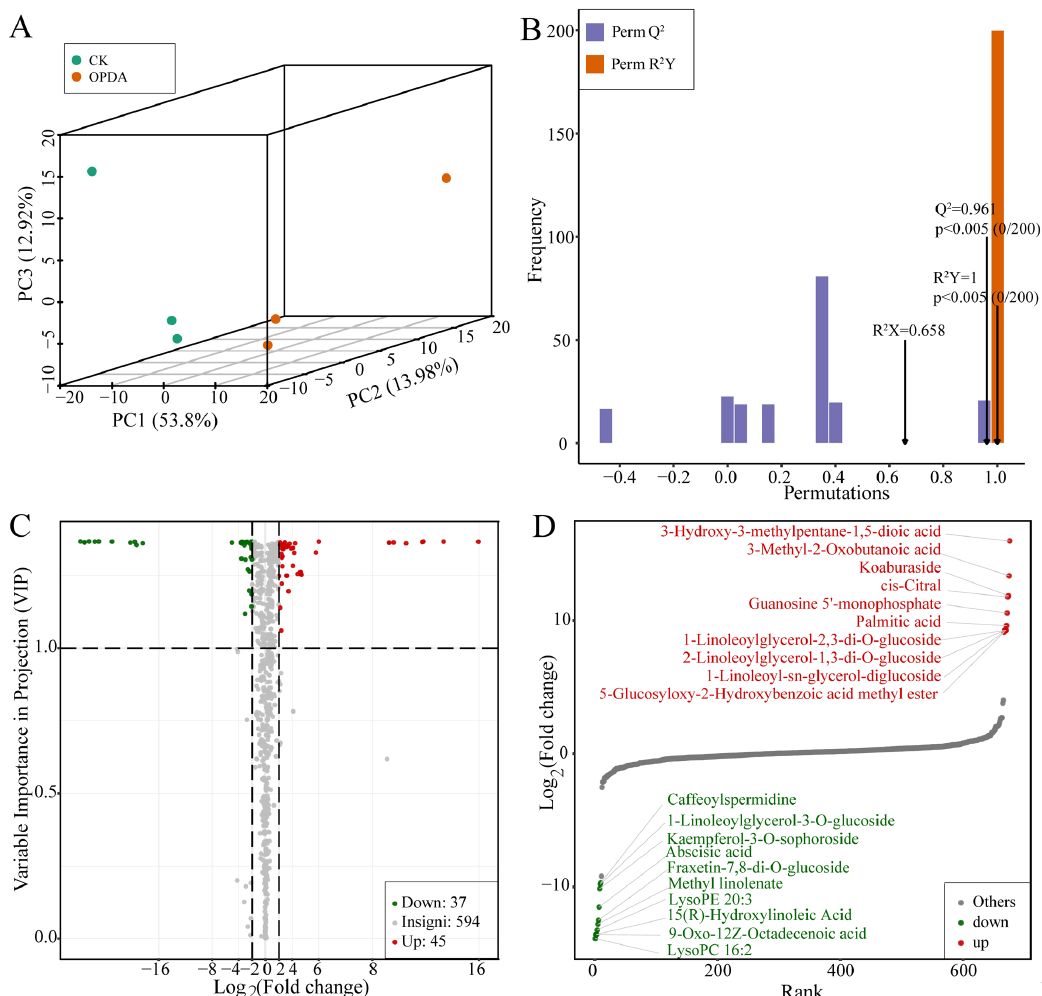
Figure 1. Identification of differently accumulated metabolites in Pohlia nutans under OPDA treatment. ( A ) Principal clustering analysis for OPDA treatment and control groups. CK, control group; OPDA, OPDA treatment group. ( B ) OPLS-DA was used to supervise and calculate variables respon- sible for group differences. R 2 X and R 2 Y represent the interpretation rate of X and Y matrix, respec- tively, while Q 2 Y indicates the prediction ability of the model. The model is more stable and reliable if the value is closer to 1. Additionally, a model with Q 2 Y > 0.5 is considered effective, and a model with Q 2 Y > 0.9 is considered excellent. ( C ) Volcanic plot showing metabolite contents and statistical significance. Each point represents a metabolite. A horizontal ordinate represents the fold change in metabolites between two groups, while a VIP value indicates a significant difference in statistical analysis. ( D ) The top 20 differently changed metabolites between two groups were selected with the values of fold change. We found 82 significantly changed metabolites (SCMs), with 45 upregulated and 37 downregulated, between the treatment and control with the criteria of |log 2 Fold Change| ≥ 1 and variable importance in project ( VIP) ≥ 1 (Figure 1C, Table S2). According to the values of log 2 (Fold change), the top 20 SCMs were identified and are shown in a graphical plot (Figure 1D). Among them, 3-Hydroxy-3-methylpentane-1,5-dioic acid belonged to amino acids and derivatives and was the most markedly accumulated compound with log 2 (Fold Change) of 15.97. In addition, 3-Methyl-2-oxobutanoic acid, a kind of organic